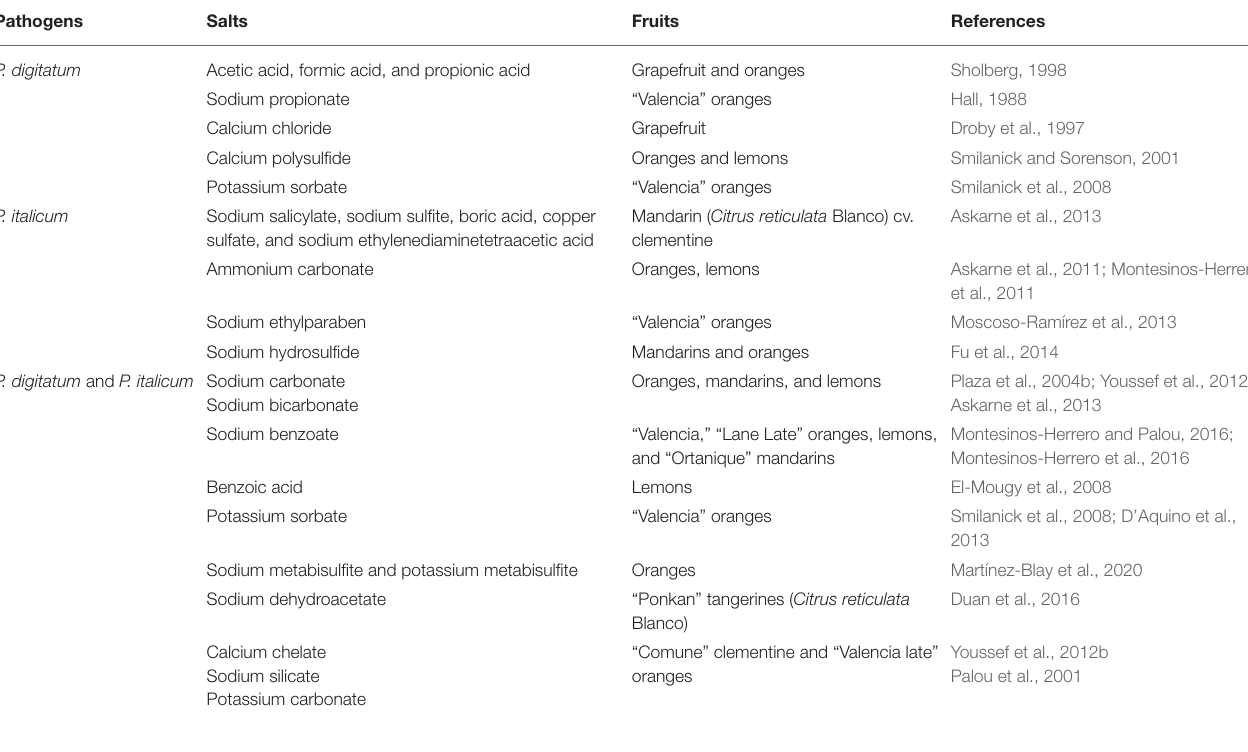
TABLE 3 | Salts and food additives for the control of P. digitatum and P. italicum .